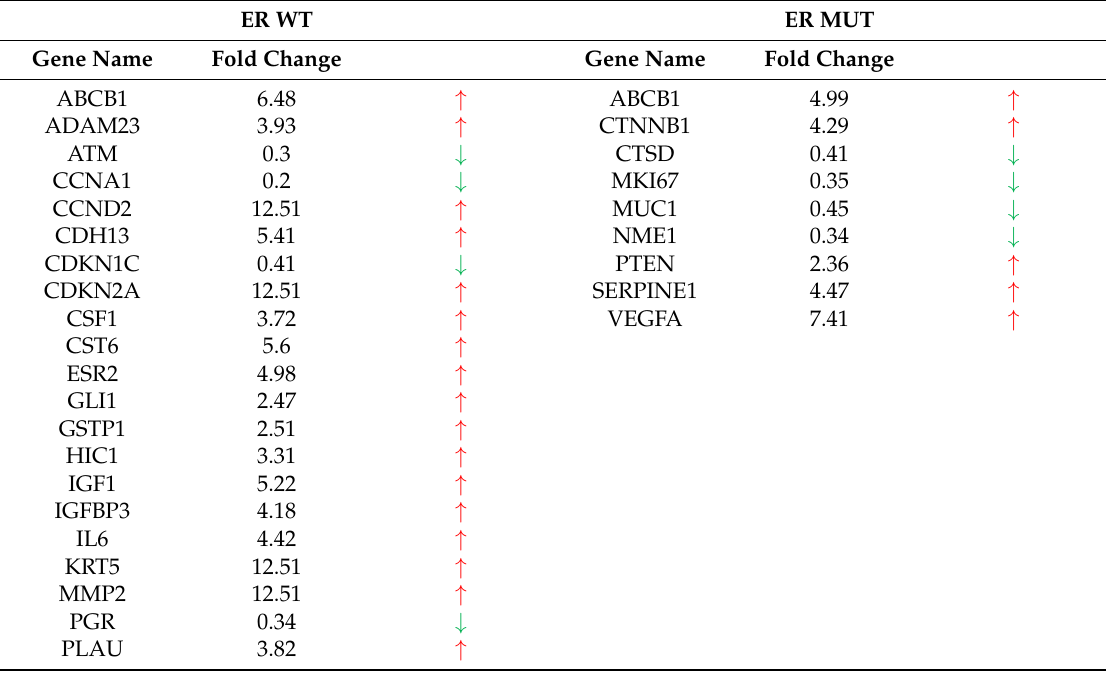
Table 1. PCR array fold changes of genes upregulated (red arrow) and downregulated (green arrow) by obASCs in ER WT (MCF7) and ER MUT (PDX-derived WHIM43) cells. This table demonstrates the specific genes and fold changes in gene expression after 96-h Transwell co-culture with pooled donors of obASCs. PCR arrays were conducted with an n = 1 for each